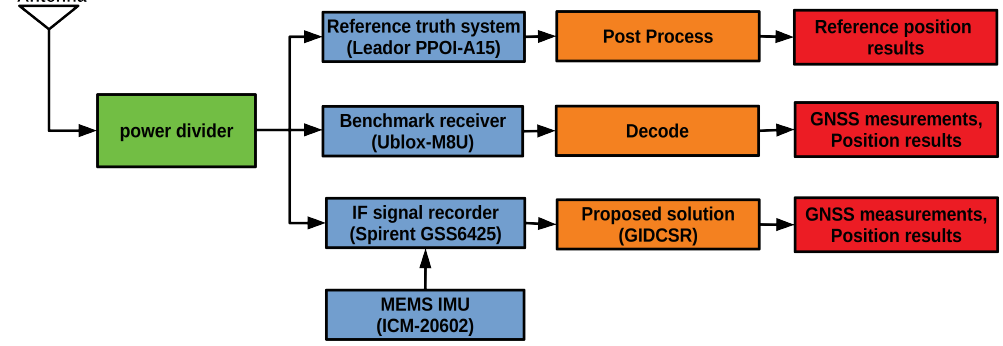
Figure 9. Scheme of